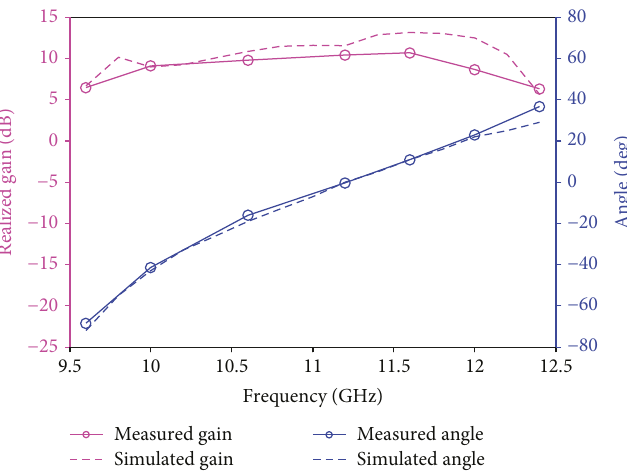
Figure 6: Beam angle and realized gain of the antenna.